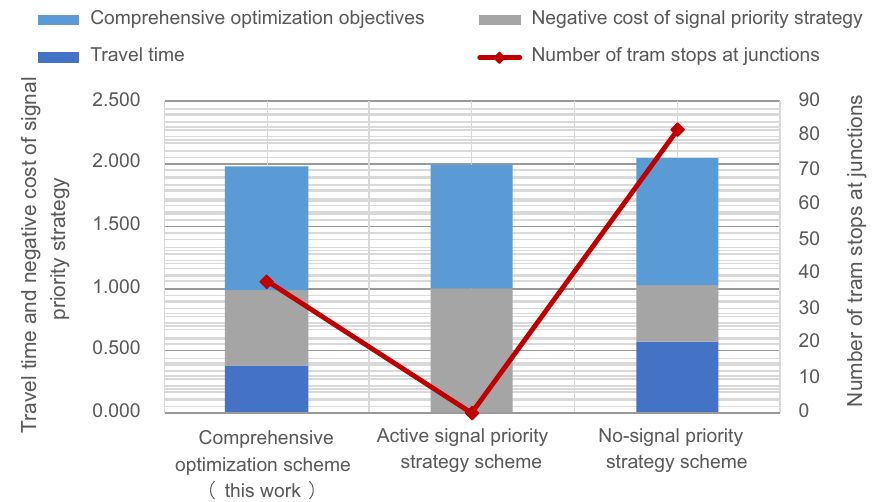
Figure 8. Comparison of comprehensive optimization objectives of trams for different schemes.